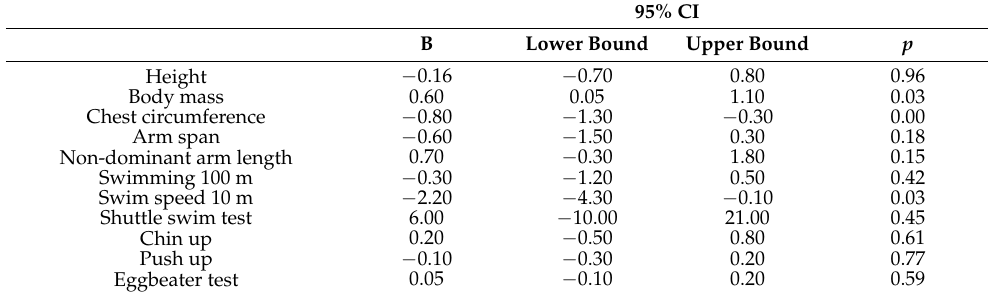
Table 3. Multiple regression results of the independent variables. B: unstandardized regression coefficient.